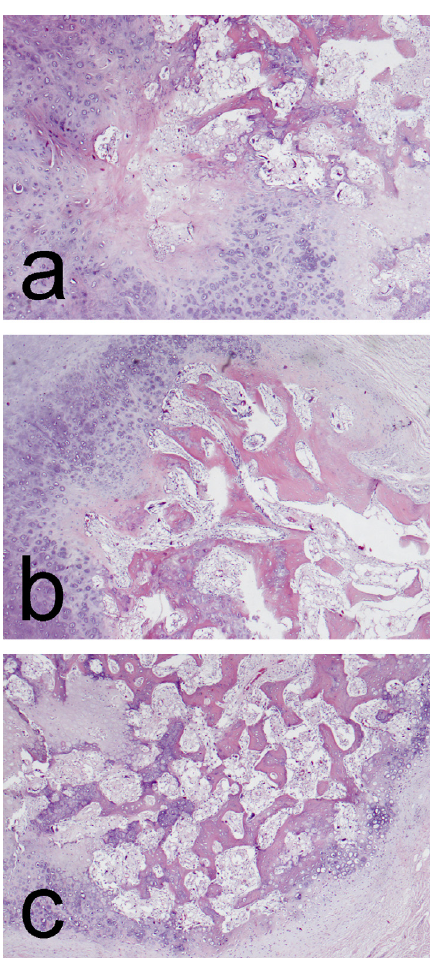
material revealed a well presented cap of hyaline cartilage gradually changing into trabecular bone (hematoxylin and eosin, · 40).